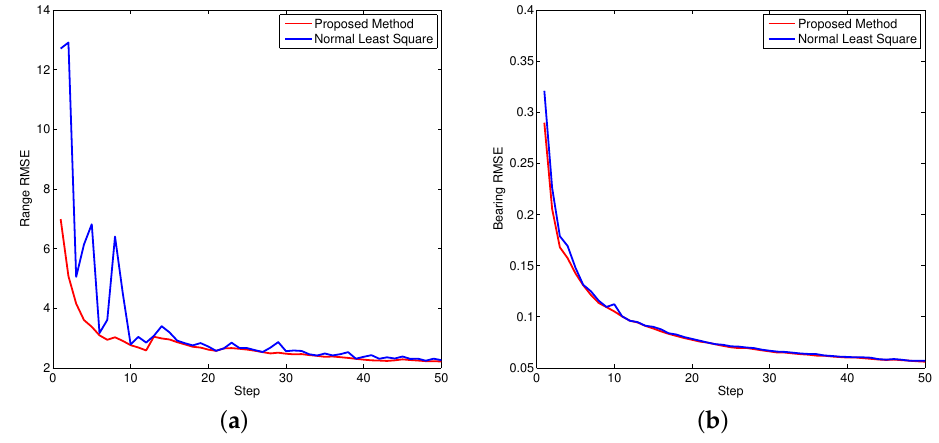
Figure 8. Bias root mean square equation (RMSE) for object one. ( a ) Bias RMSE in range; ( b ) Bias RMSE in bearing.